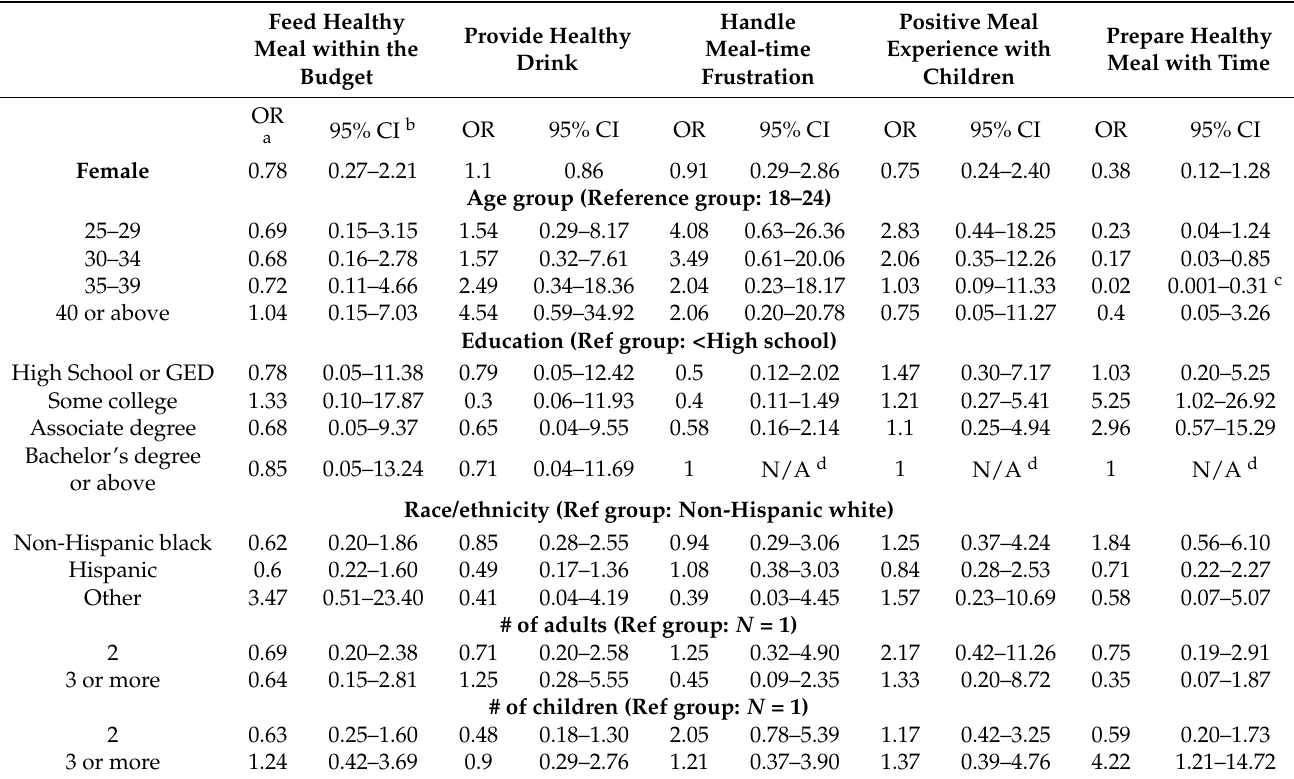
Table 4. Logistic regression of improvement in self-efficacy in healthy eating among new Cooking Matters Facebook followers ( n =